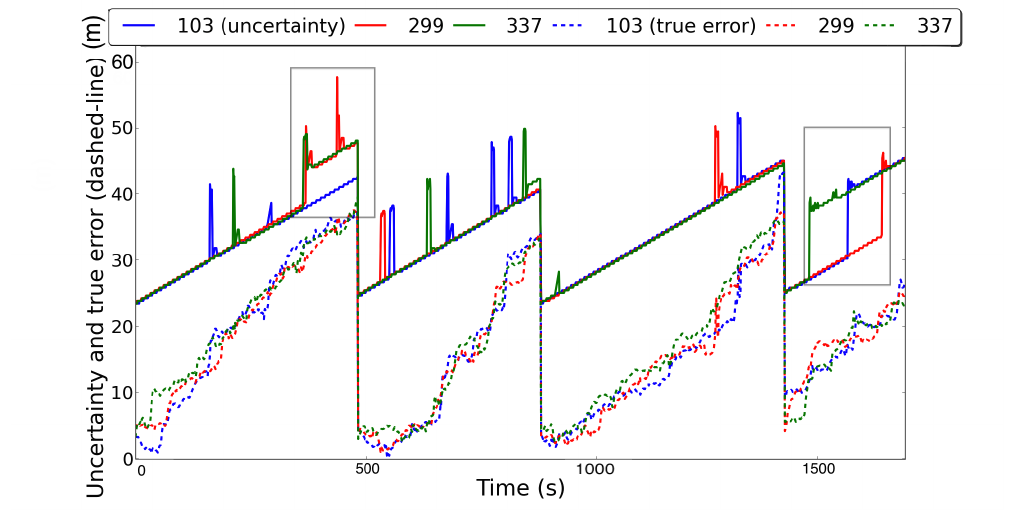
Figure 6. The growth of uncertainty with accelerometer duty cycling. The narrow peaks correspond to accelerometer motion